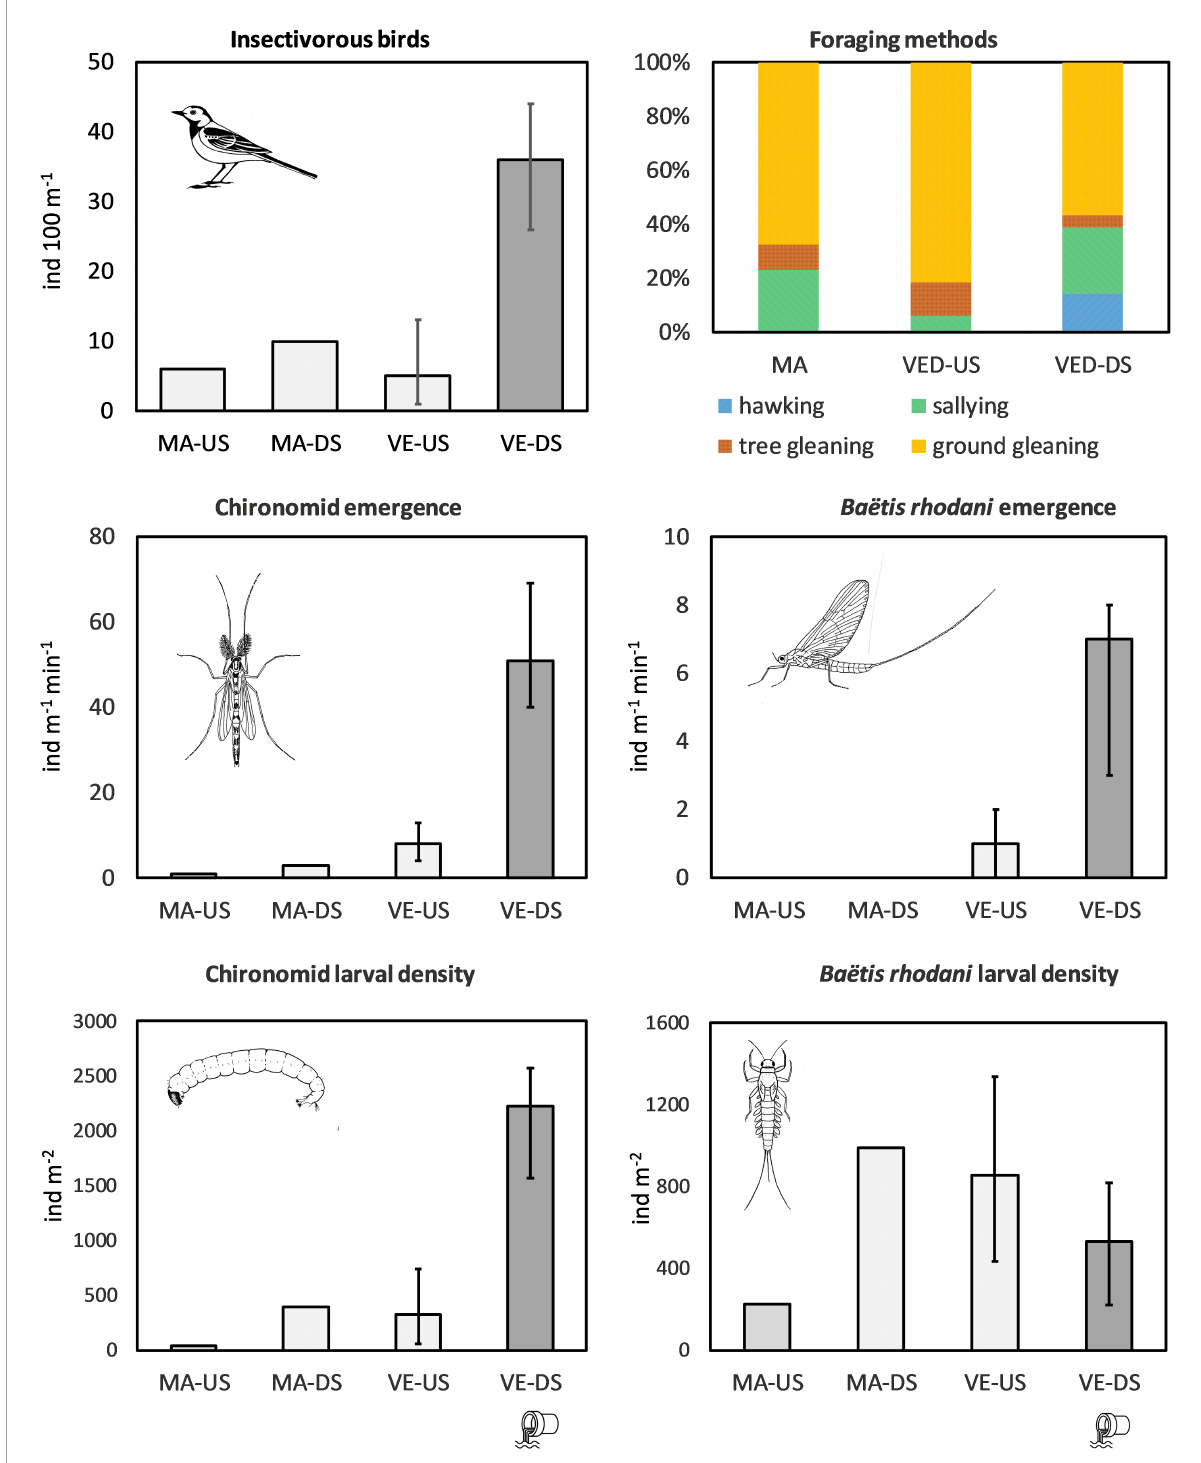
FIGURE1 Top right: bird foraging methods in percentage (average within MA, VED-US, and VED-DS sites). Other charts: average (VED-US and VED-DS) or total (MAG-US and MAG-DS) insectivorous-bird linear density, larval chironomid and Baëtis rhodani density, and chironomid and Baëtis rhodani emergence rate. Error bars indicate maximum and minimum values within VED-US sites ( n = 4) and VED-DS sites ( n =